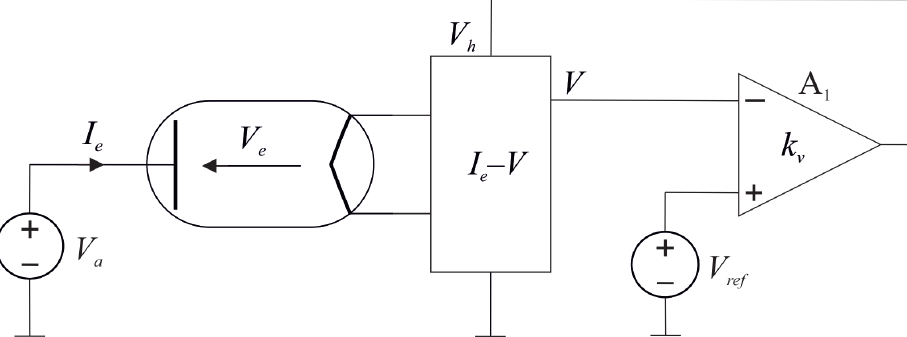
Figure 11. A simplified scheme of the controller of the emitted electron current using a cathode converter. A1 is the k v voltage transmittance amplifier, V ref is the reference